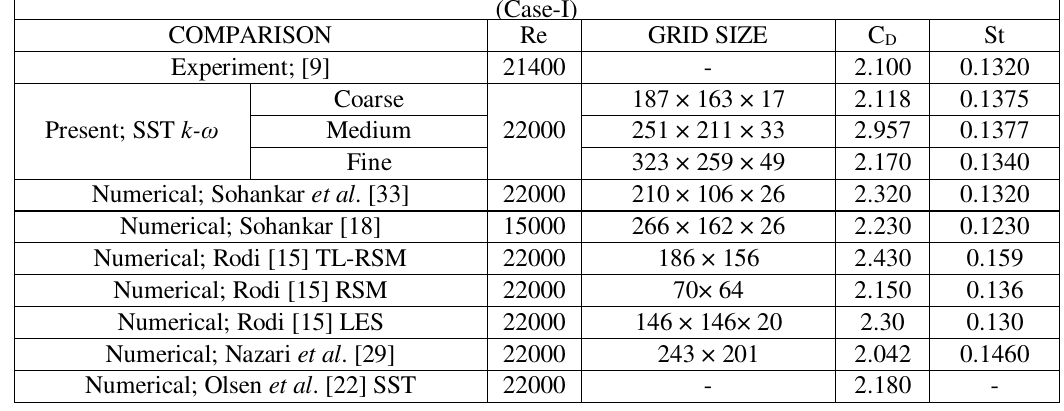
Table 3: Comparison and summarized results at different grid sizes for Single Square Cylinders